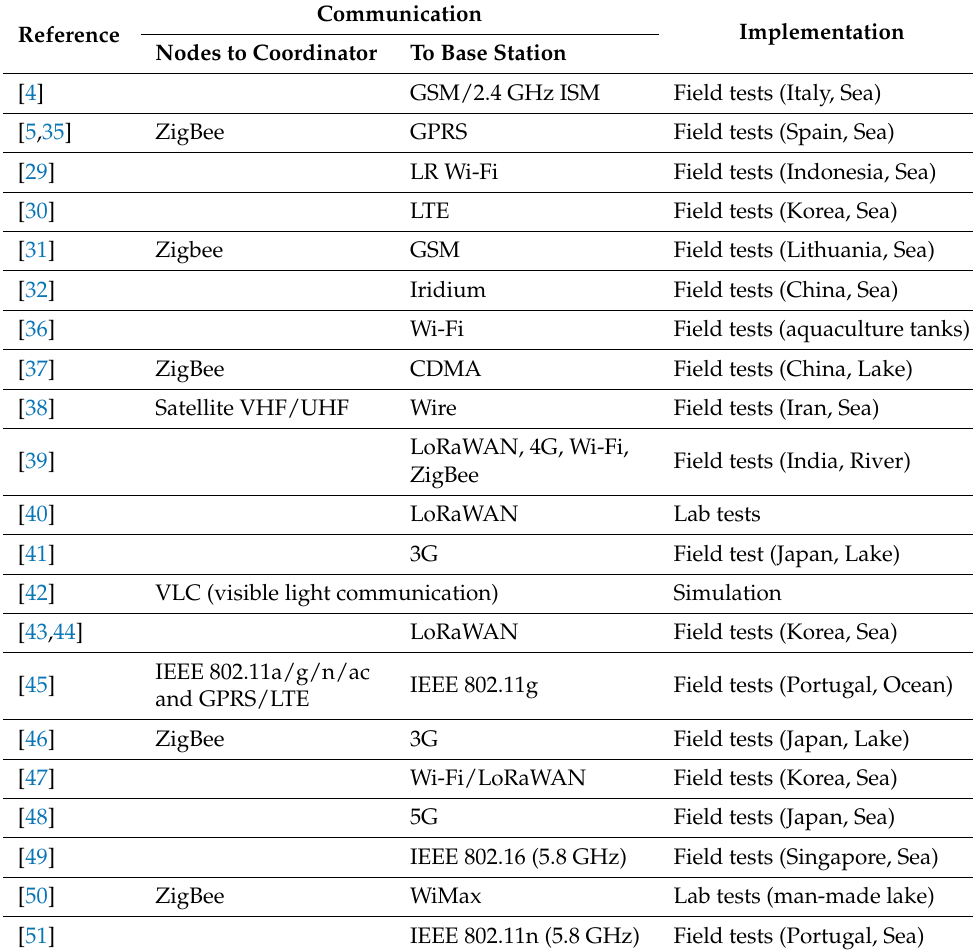
Table 3. Summary of the literature review in terms of the communication protocol implemented between nodes and coordinators and towards base stations (when applied) and the implementation of the